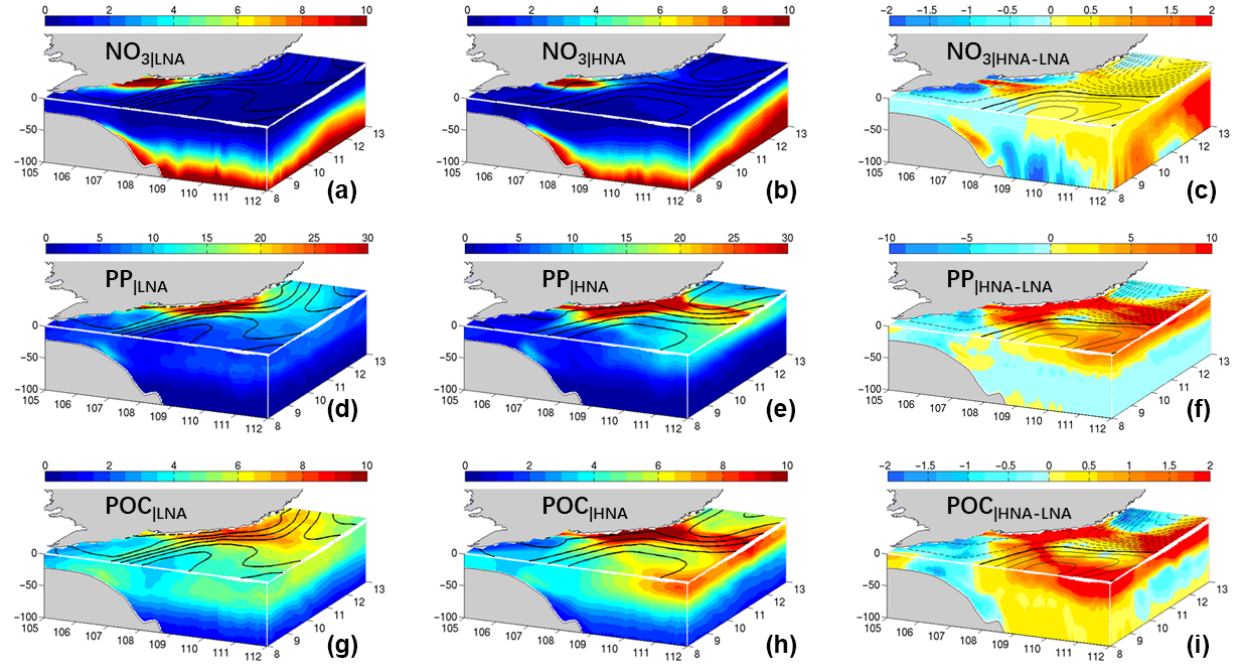
Figure 10. Modeled NO 3 ( a–c , in mmolm − 3 ), PP ( d–f , mgCm − 3 day − 1 ), and particulate organic carbon ( g–i , mmolCm − 3 ) distribution in LNA (a, d, g) , HNA (b, e, h) , and the difference between two scenarios (c, f, i) . See text for the definition of LNA and HNA.